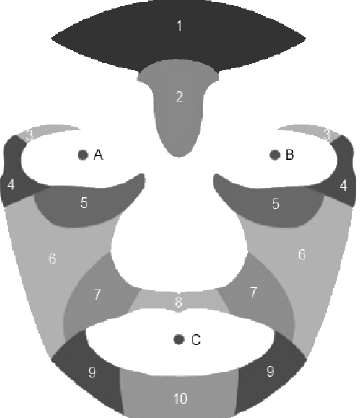
Figure 4. Facial mask with ten regions as defined by